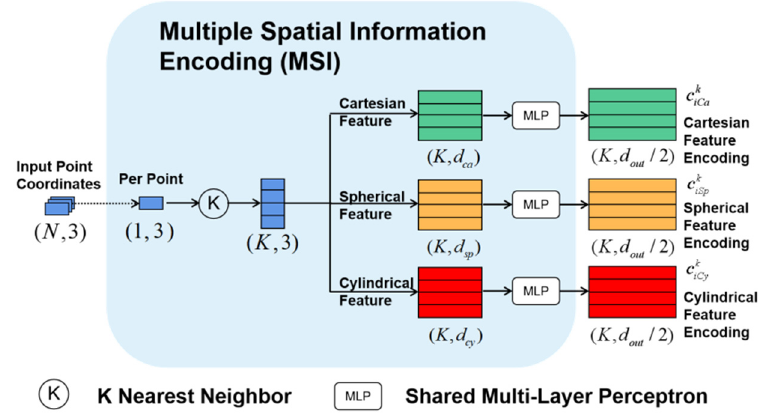
Figure 3. The architecture of the MSI